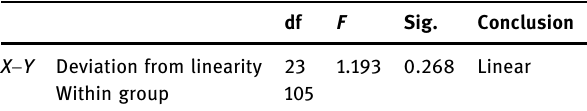
Table 4: The summary of linearity